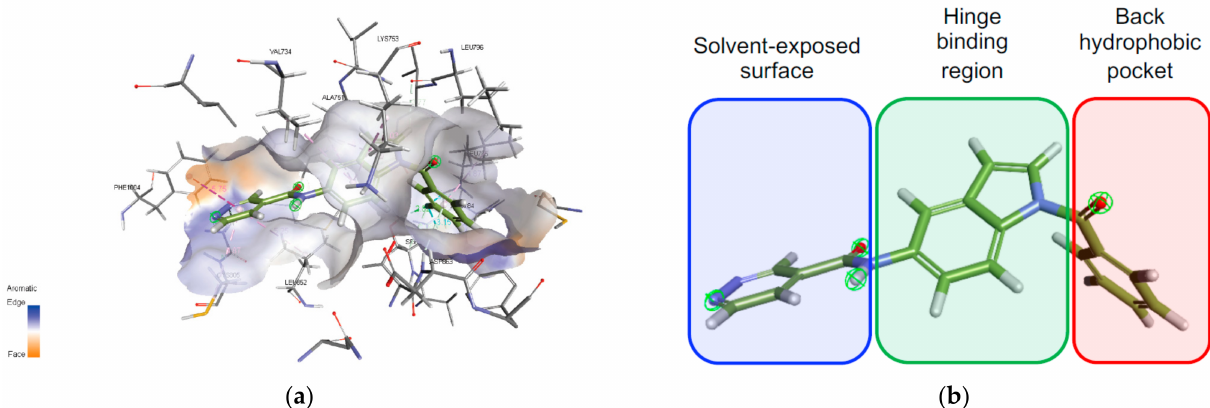
Figure 5. Binding mode of compound 15l into HER-2 active site (PDB ID: 3RCD); ( a ): 3D visualization showed the orientation of compound 15l binding motifs in the main regions of the active site; ( b ): graphical illustration of orientation of compound 15l binding motifs in the HER-2 active site. Indole-based central motif occupied hinge binding region (green color), 3-fluorophenyl ring aligned into the back groove (red color) and terminal pyridazine ring travelled out towards solvent-exposed surface (blue